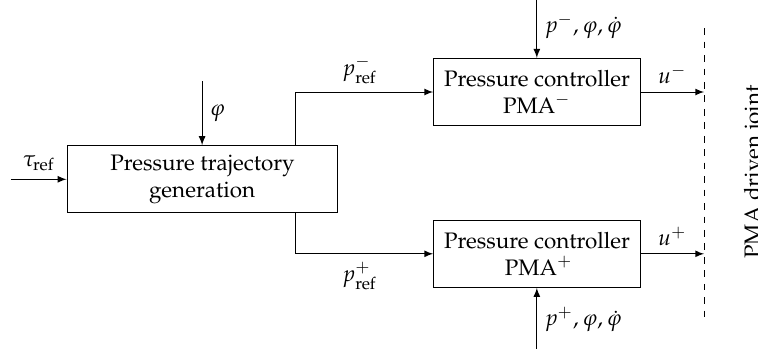
Figure 2. General structure of the sensor-less torque controller